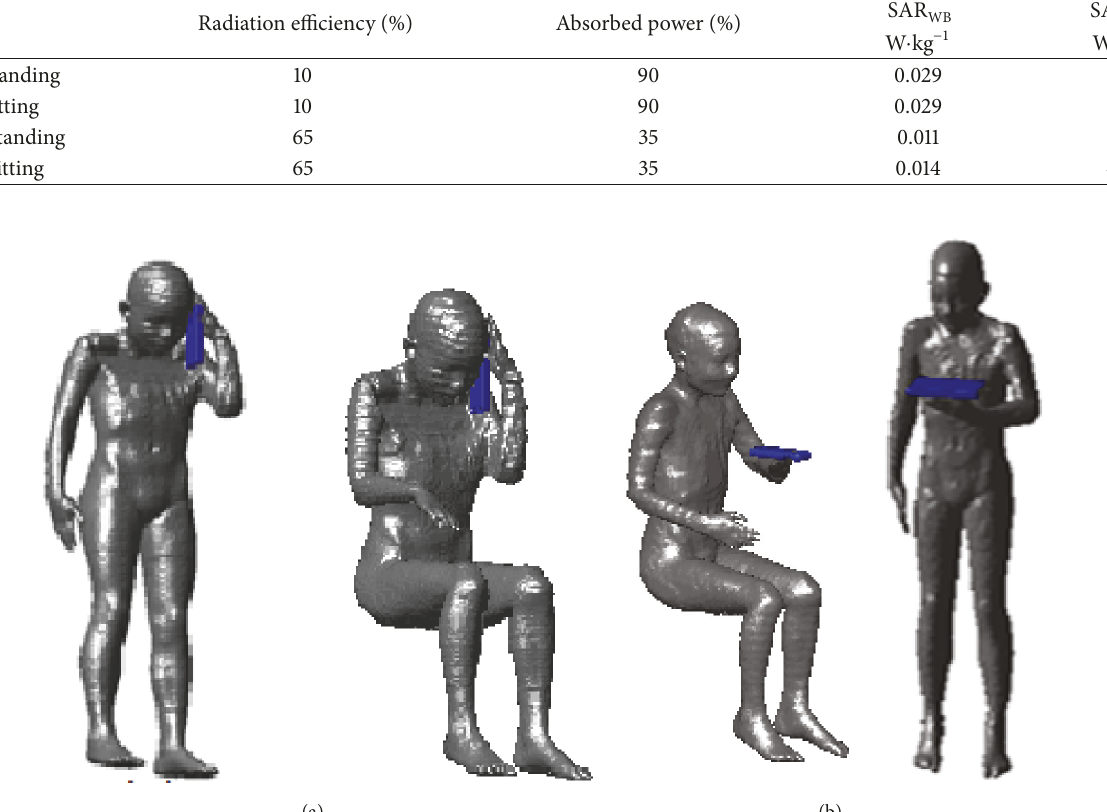
Figure 3: Different postures: (a) voice-standing and sitting and (b) data-standing and sitting.